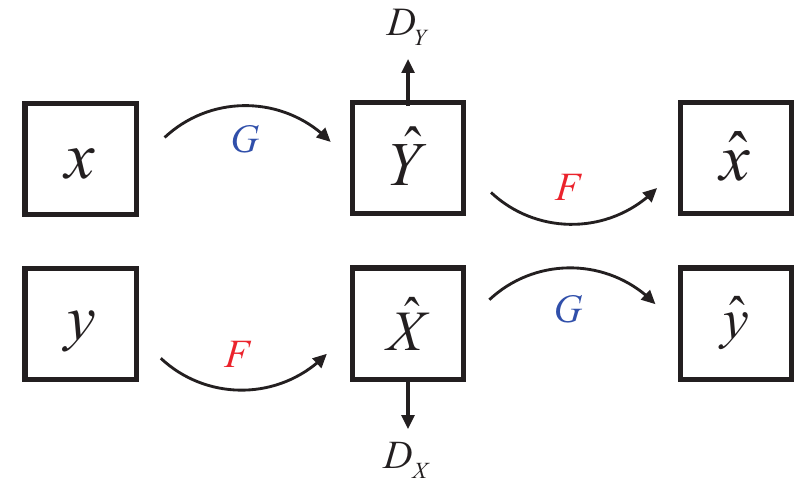
Figure 2. CycleGAN network